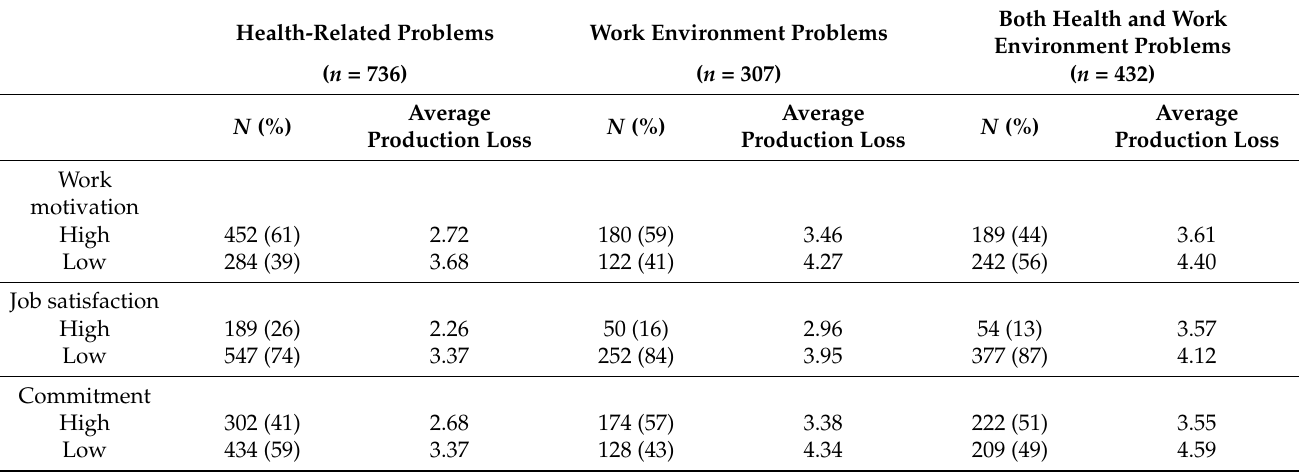
Table 2. Proportion of employees with high/low work motivation, job satisfaction and organisational commitment towards work presented for the groups with different problems, as well as the average productivity loss divided by the level of work attitudes in each